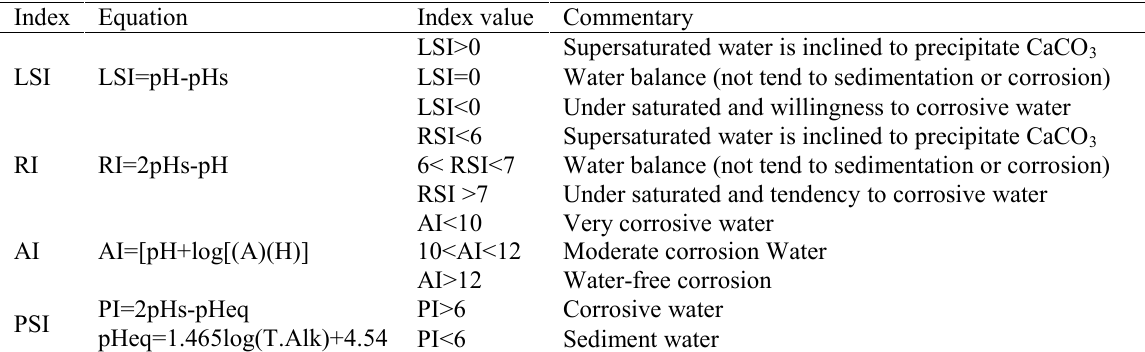
Table 1. Water Sustainability Indices